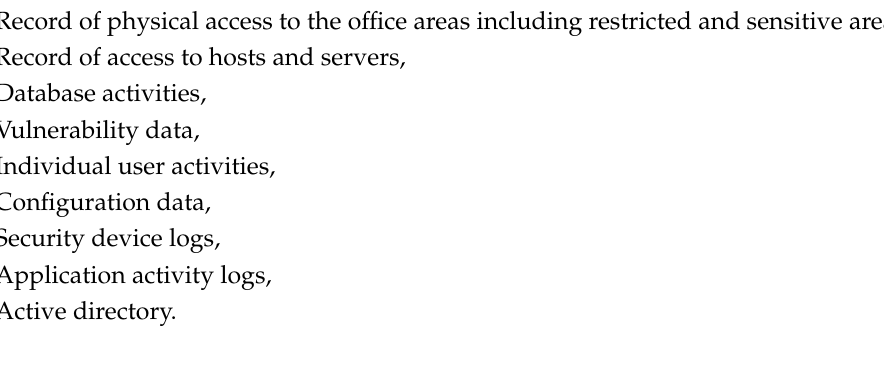
Table 4. Indicators of